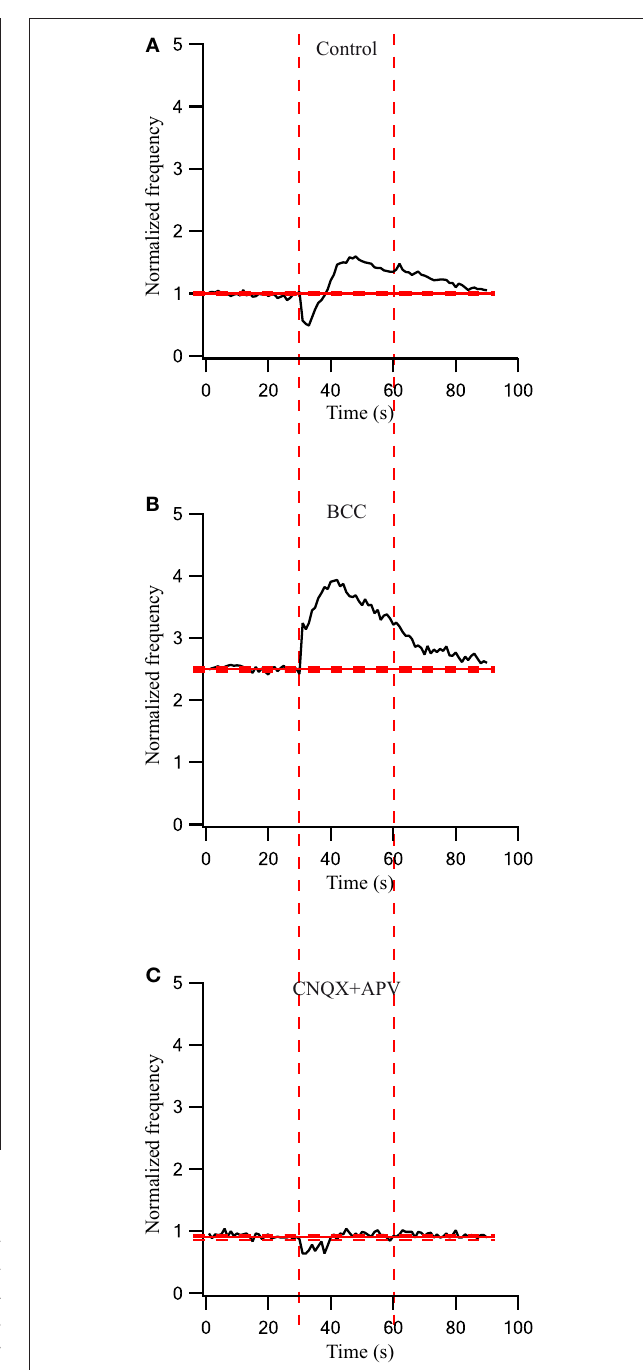
Figure 6 | Firing rate changes during stimulation at 40 Hz before and after application of gABAergic and glutamatergic antagonists. (A) Population frequency of GP neurons in normal extracellular solution ( n = 43). (B) Population frequency of GP neurons after applying 50 μM bicuculline to the extracellular solution ( n = 25). (C) Population frequency of GP neurons after applying 15 μM CNQX and 50 μM APV to the extracellular solution ( n = 13). The thick and dashed horizontal lines indicate the average and SD of pre-stimulus frequency, respectively. The dashed vertical lines mark the beginning and the end of the